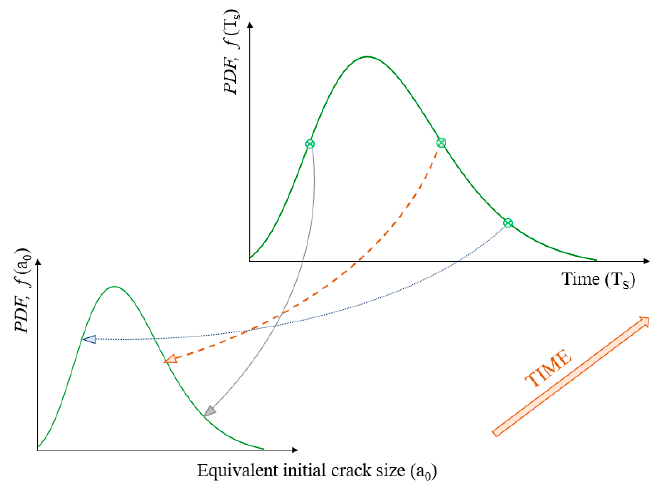
Figure 5. Obtaining the equivalent initial crack size distribution.